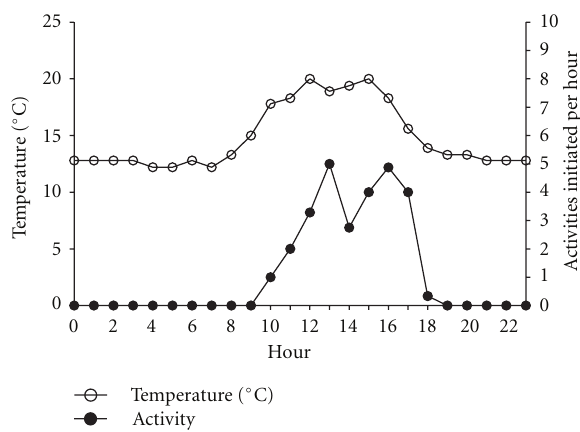
Figure 5: Relationship between O. cornifrons activity and tempera- ture. Hour 0 is 12:00 am and hour 23 is 11:00